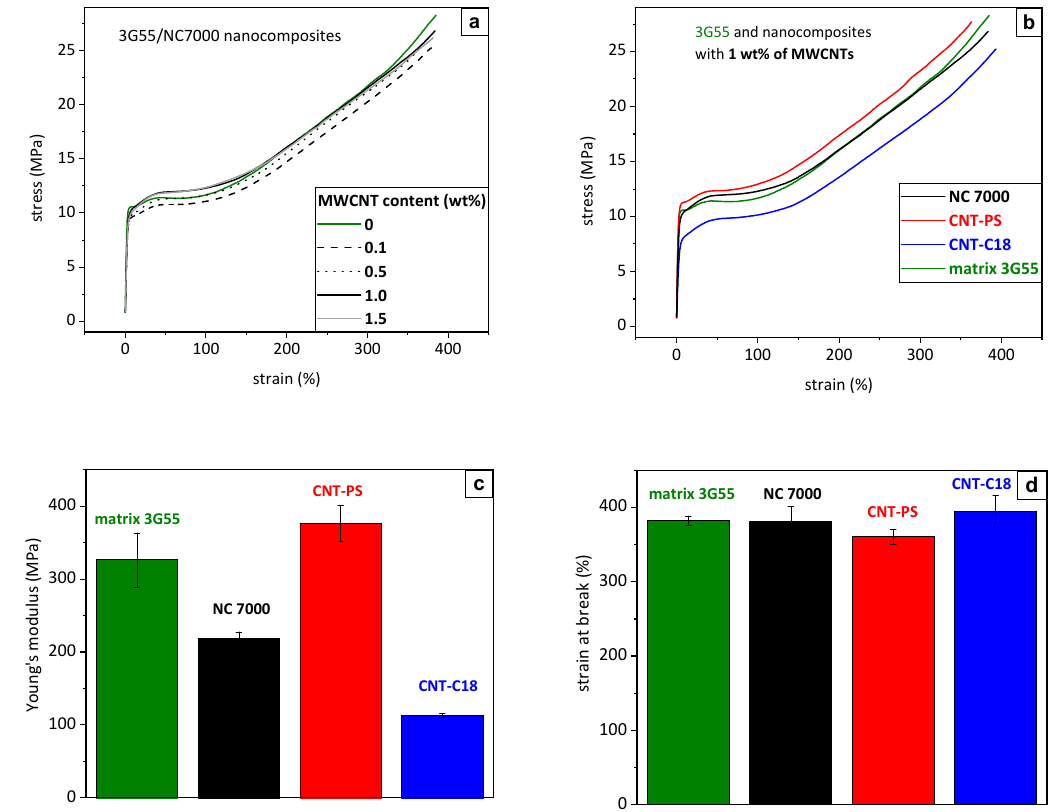
Figure 12. Mechanical properties of BCP/MWCNT composites: ( a ) stress–strain diagrams of 3G55/NC7000 composites, ( b ) stress–strain diagrams, ( c ) Young’s modulus and ( d ) strain at break of 3G55 and nanocomposites with 1 wt % of